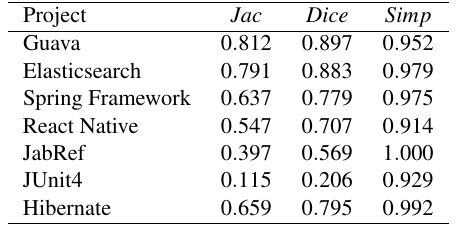
Table 2. Similarities between violation sets: single-authored files vs. multi-authored files. Project